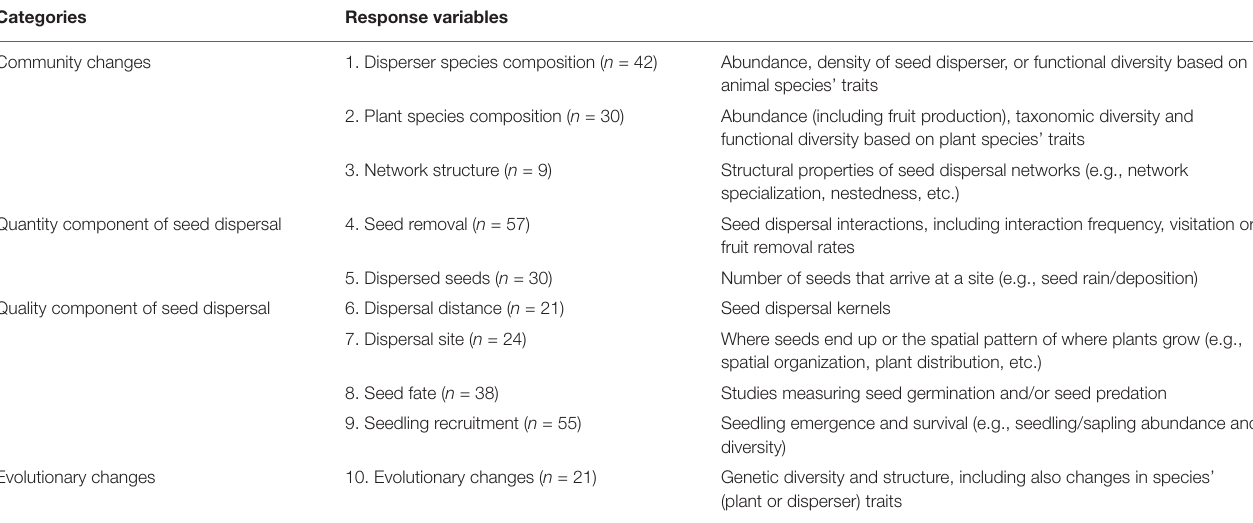
TABLE 2 | Categorization of the main mechanisms by which the different drivers of global change interfere with the seed dispersal process.